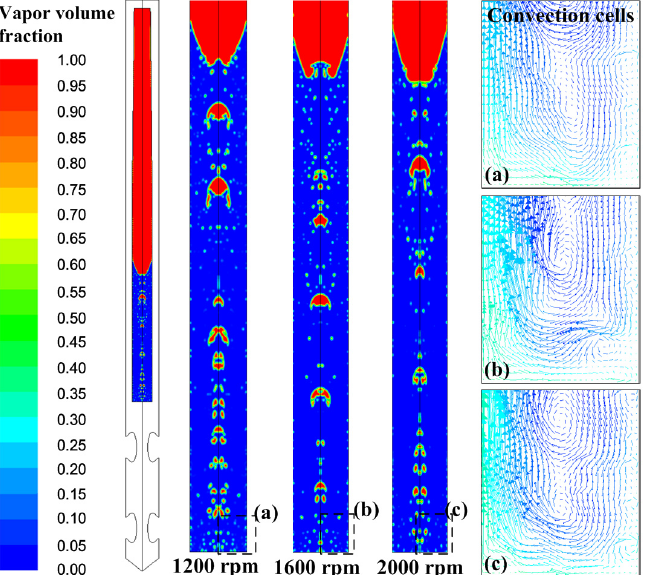
Figure 14. Heat transfer in the evaporator under different rotational speed. ( a ) 1200 rpm; ( b ) 1600 rpm; ( c ) 2000 rpm.